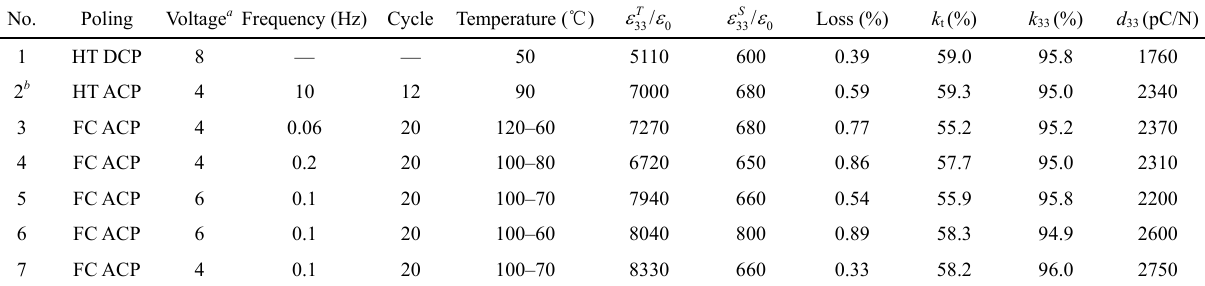
Table 1 Poling conditions and electrical properties of PIMN–0.30PT SCs